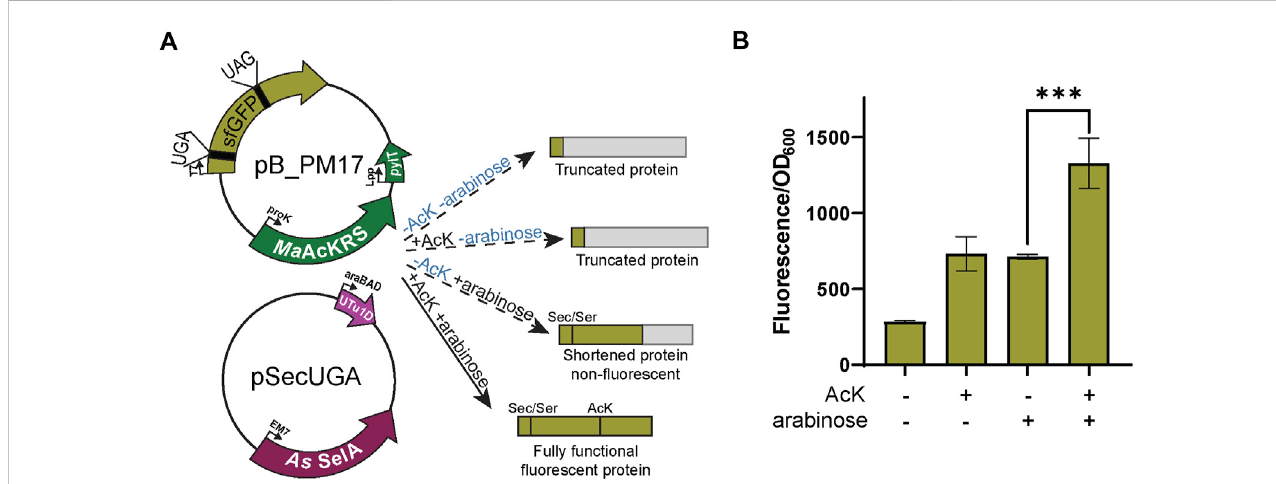
FIGURE 4 Fluorescence from dual suppression in sfGFP. (A) The assay was performed with a two-plasmid system: pB_PM14 and pSecUGA. The fi rst plasmid containsthegenesfor Ma AcKRS3-IPandtRNA Pyl CUA ( pylT )forinsertionof N ε -acetyl- L -lysine(AcK)ataUAGandpSecUGAcontainsthemachineryforinsertion ofSecataUGA.InthepresenceofAcK,arabinose,andsodiumselenite,theentiresfGFPgeneshouldbeexpressedtoproduce fl uorescence.Intheabsenceof AcK or arabinose (or both), translation stops resulting in truncated non- fl uorescent protein. Without arabinose, only the fi rst amino acid would be translated. Without AcK, translation would continue until the UAG at position 151 to produce a truncated protein. (B) sfGFP assay shows successful readthroughofboth codons inthepresence ofAcK and Secwith asigni fi cantincreasein fl uorescence ( p < 0.001) compared to when onlyone ornone ofthe componentswereadded.Dataareshownastheaverageofatleastfourbiologicalreplicateswiththecorrespondingstandarddeviationshownwitherrorbars.